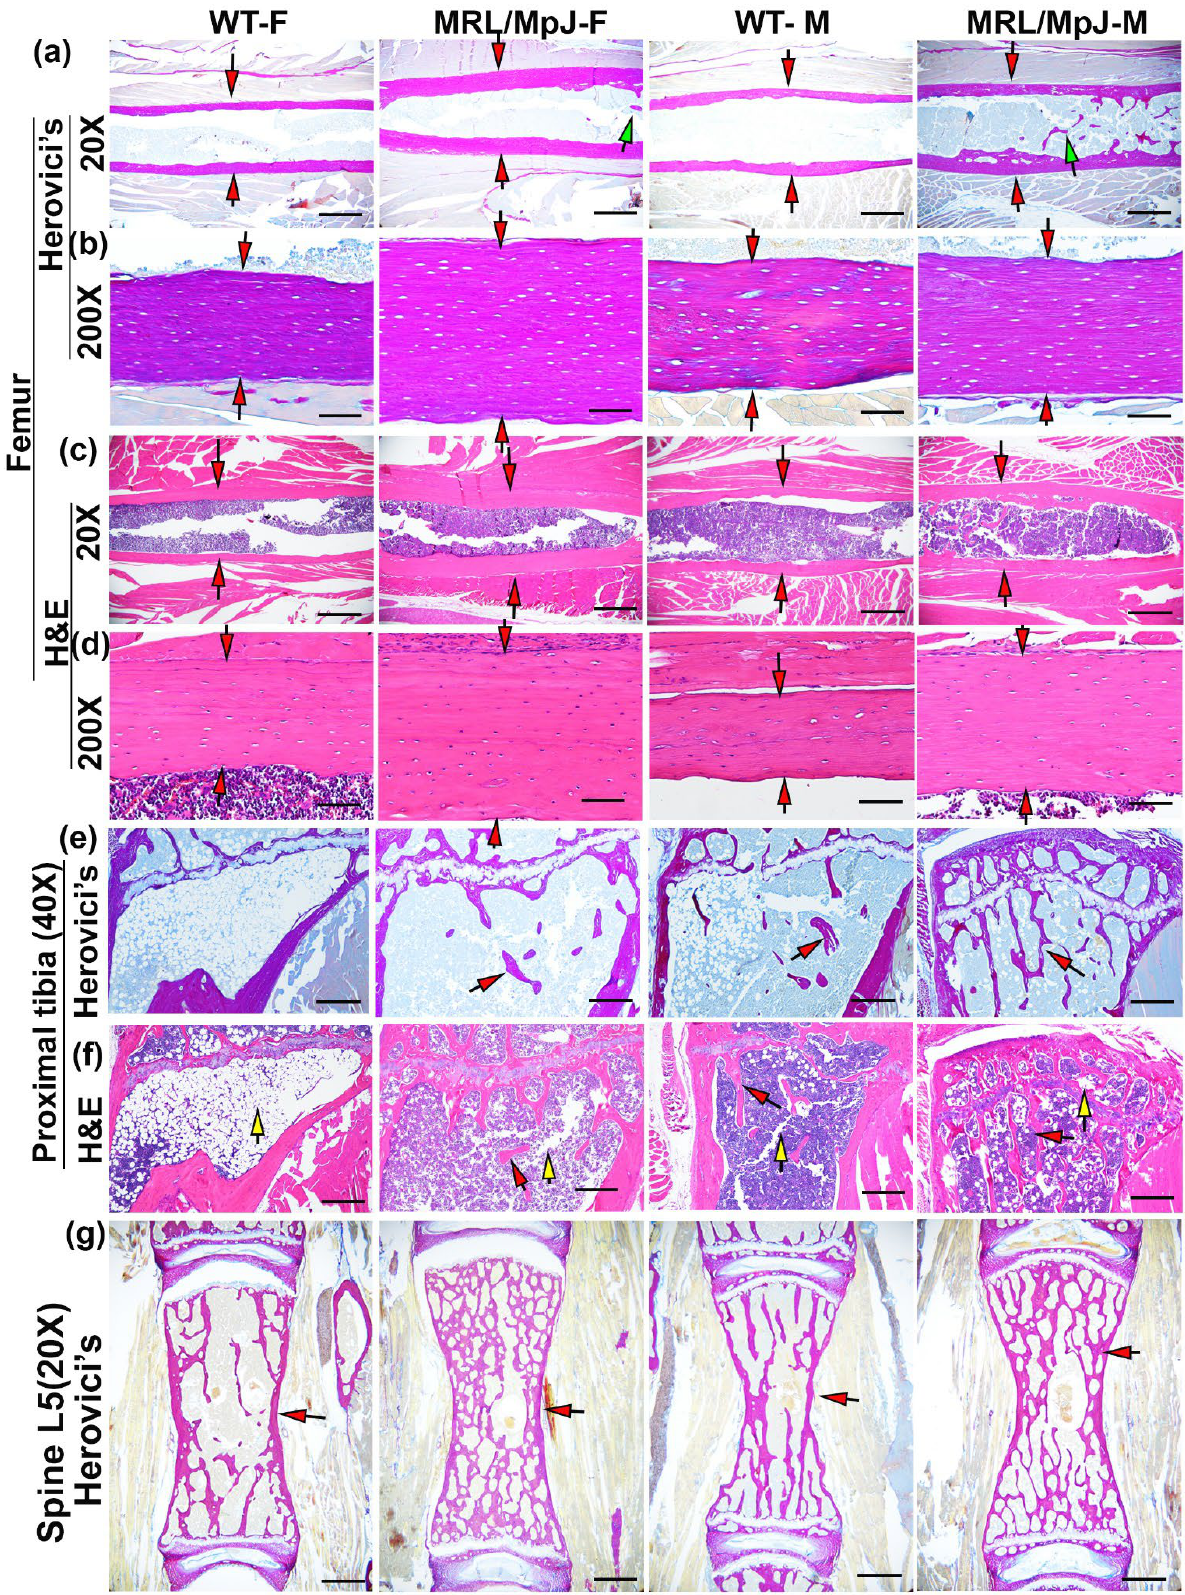
Figure 2. Histology of bone tissues of MRL/MpJ and WT mice at 14 M. ( a ) Herovici’s staining of femoral cortical bone at 20 × magnification. Collagen type 1 (major bone matrix) stained pink-red and collagen type 3 stained dark blue. MRL/MJ-F and MRL/MpJ-M all showed thicker red cortical